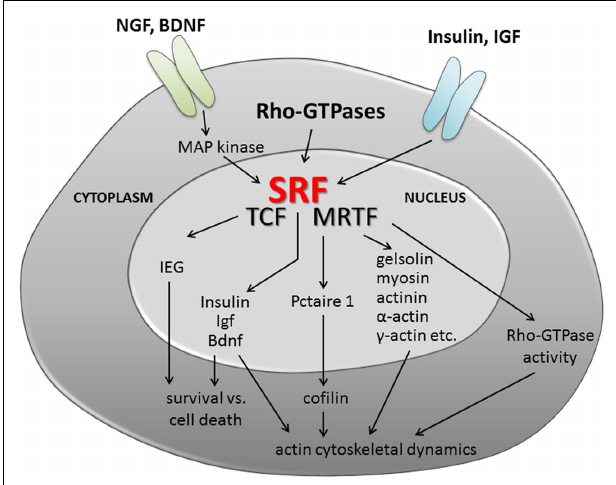
FIGURE 2 | Serum response factor signaling in neuronal motility. Summary of potential upstream signaling cascades activating SRF and/or TCF/MRTF cofactor activity. In addition, possible scenarios on the impact of SRF-mediated gene transcription on neuronal differentiation and axonal regeneration are provided.The latter include regulation of cell survival (e.g., via IEGs, neurotrophin , and insulin growth factors) and cytoskeletal dynamics. Here, SRF and most likely MRTFs will adjust mRNA levels of genes encoding cytoskeletal genes (gelsolin, actin isoforms, etc.) and modulate activity of the actin severing protein cofilin. Further, SRF might adjust Rho-GTPase activity and thereby modulate actin (and microtubule)